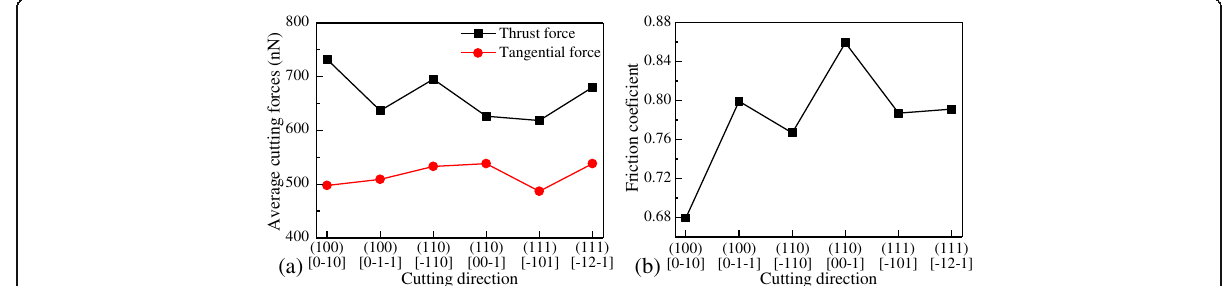
Fig. 9 a Average cutting forces and b friction coefficient at the balanced phase